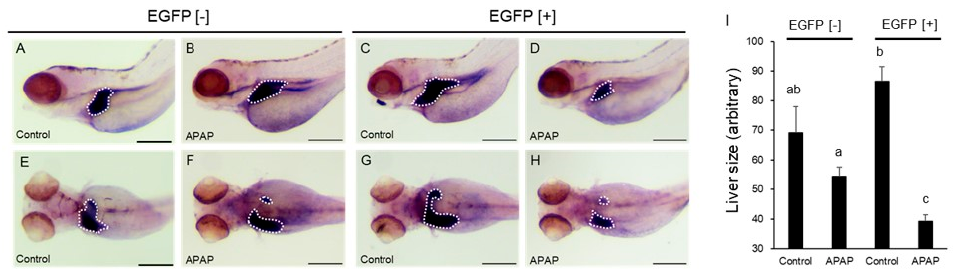
Figure 5. Acetaminophen-induced reduction in the size of the expression area of a hepatocyte marker in rat CYP2E1-TG larvae. EGFP fluorescence-negative (EGFP [ − ]) and -positive (EGFP [+]) F2 rat CYP2E1-transgenic larvae were exposed to 2.5 mM acetaminophen (APAP) from 48 hpf to 96 hpf. The larvae were fixed for whole-mount in situ hybridization with a fabp10a probe, a hepatocyte marker. The white-dotted circle indicates an outline of the liver. ( A , B , E , F ): EGFP [ − ] larvae. ( C , D , G , H ): EGFP [+] larvae. ( E – H ) are dorsal images of larvae of ( A – D ), respectively. Scale bar: 200 µm. (I) indicates averages of the expression area from a dorsal view for each treatment ( n = 10 or 12). Bars with different letters in I (a, ab, b, c) are significantly different ( p < 0.05).